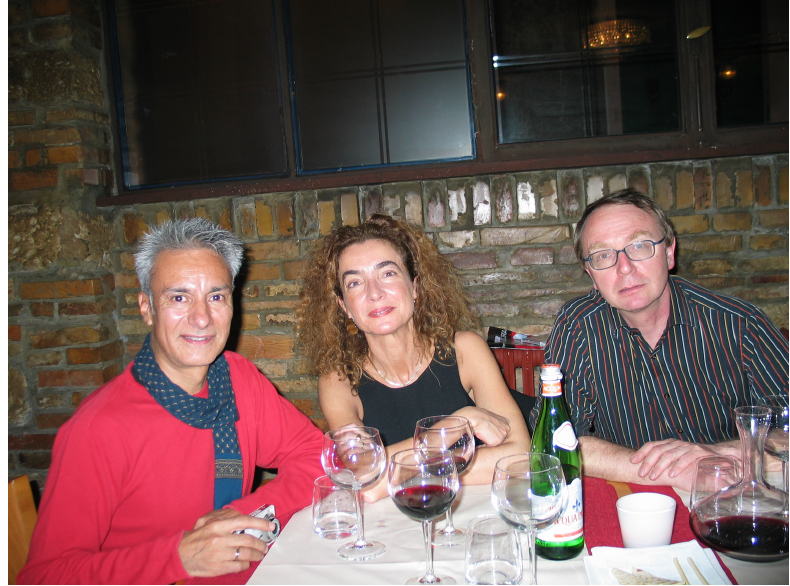
Figure 2 – Reinaldo Arellano-Valle, Antonella Capitanio, and Adelchi Azzalini (left to right). N.B. : I think Adelchi has already pointed out the special characteristics that An- tonella possessed and brought to the field. The question was what sort of lessons